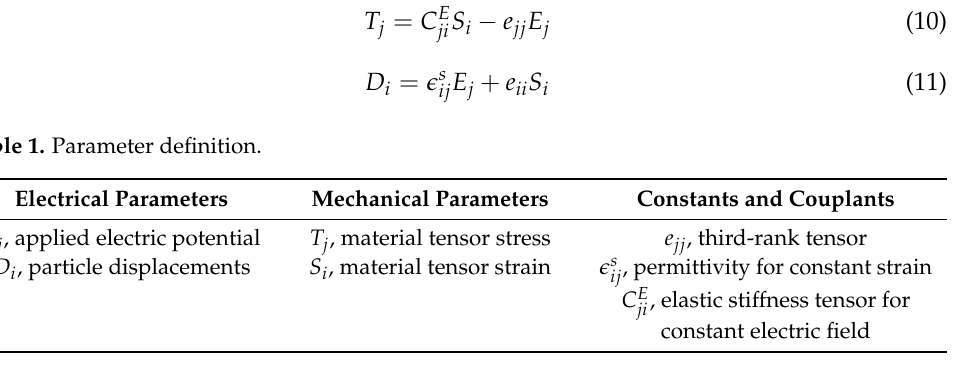
Table 1. Parameter definition. Electrical Parameters Mechanical Parameters Constants and Couplants